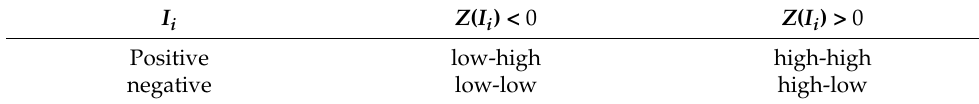
Table 3. Corresponding values of time–space